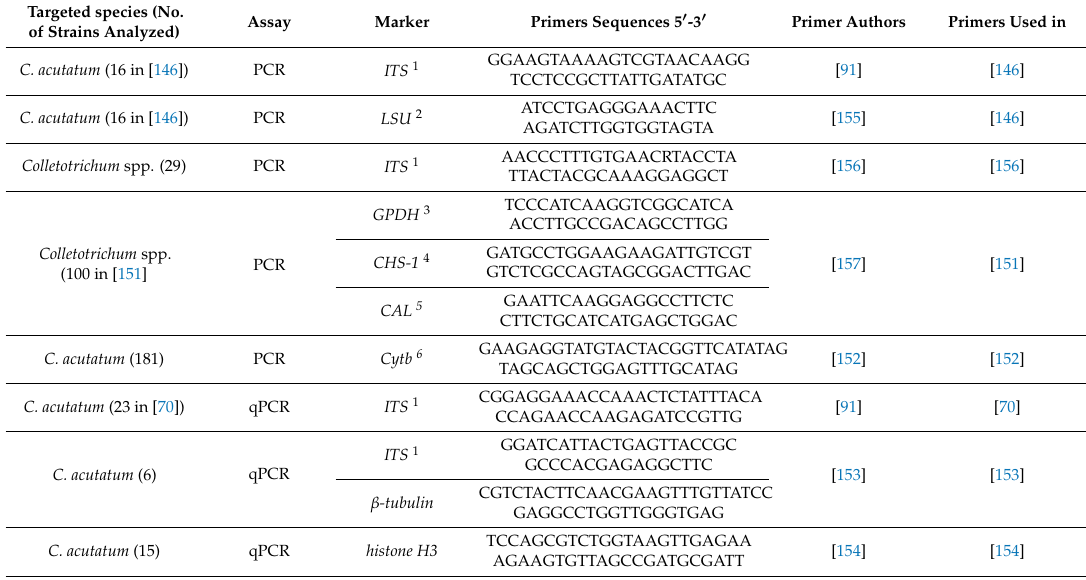
Table 5. Selected primers designed for molecular analysis of Colletotrichum